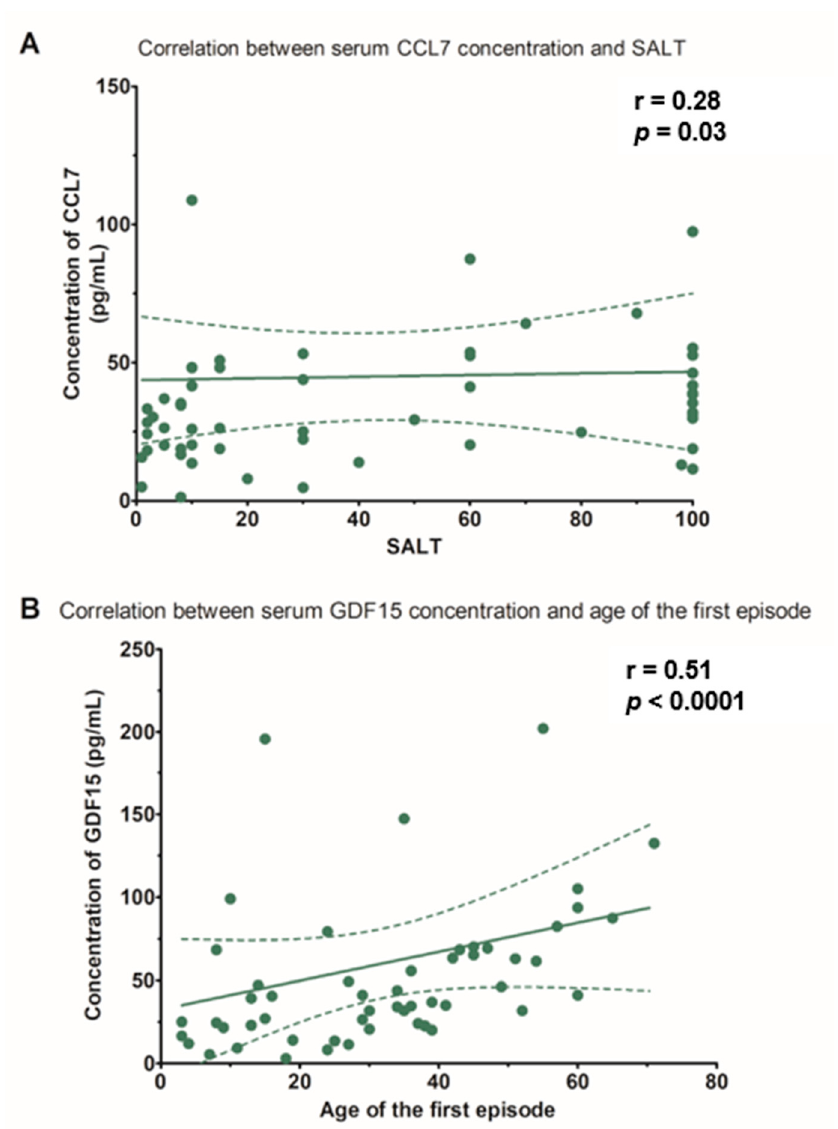
Figure 1. ( A ) Correlation between the serum concentrations of chemokine C-C motif ligand 7 (CCL7) and the severity of hair loss in patients with alopecia areata, evaluated with the severity of alopecia tool (SALT). ( B ) Correlation between the serum concentrations of growth differentiation factor 15 (GDF15) and patient age at the first episode of alopecia areata. The comparison between patients with a SALT score < 50% and healthy subjects revealed no significant differences in the serum levels of various atherosclerosis and cardiovascular markers (Table 3).